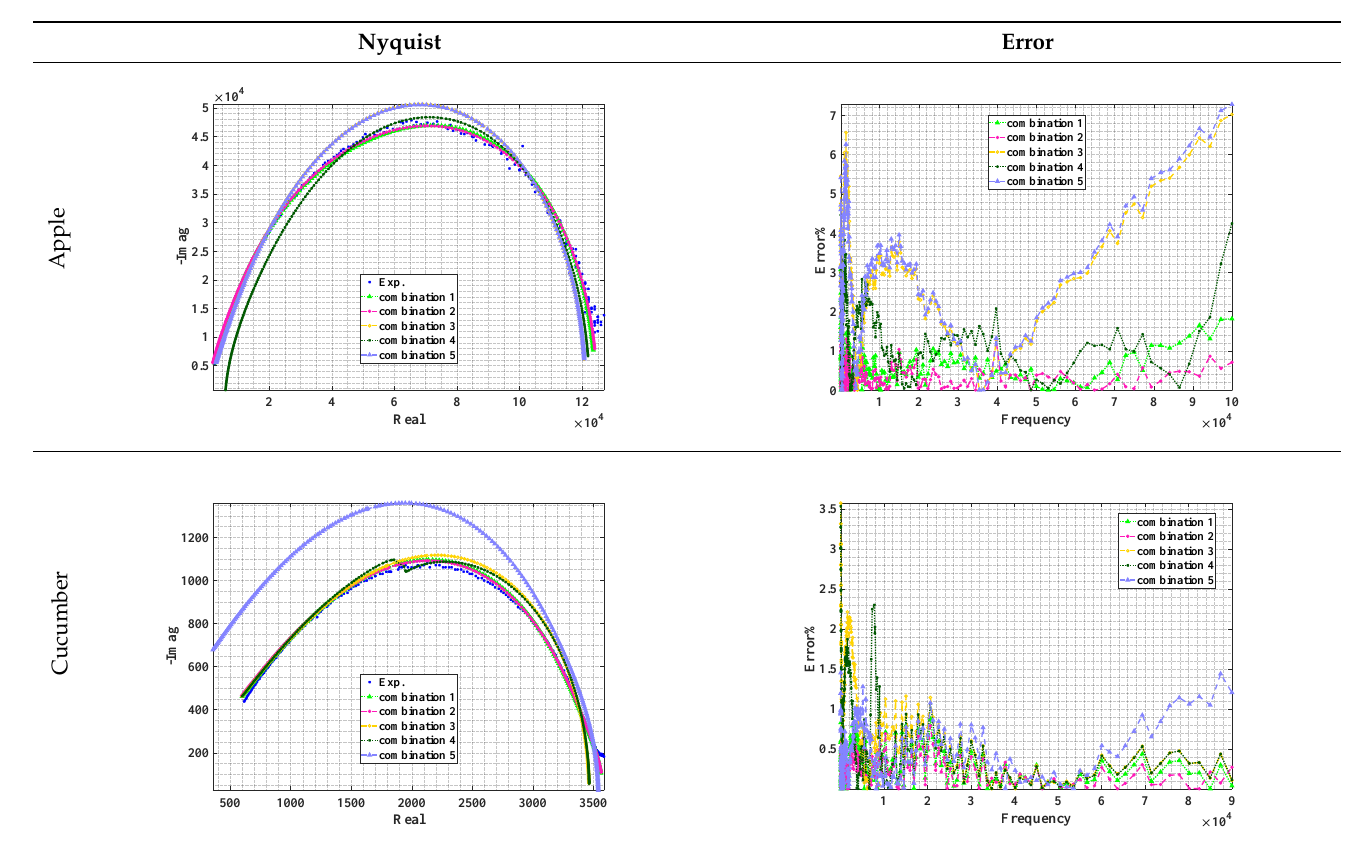
Table 3. Using WCA optimisation, the Nyquist and error plot of the experimental and the fitted double